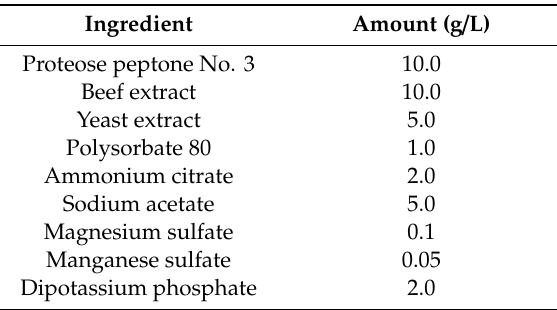
Table 2. Components of the modified MRS media.